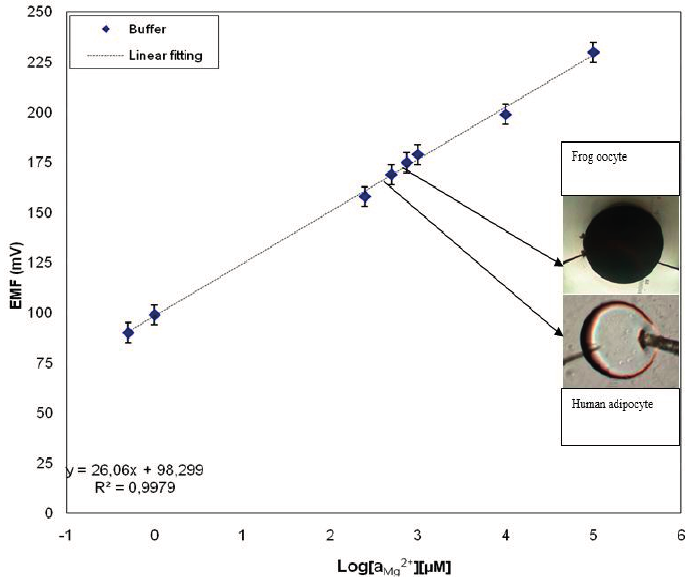
Figure 7. A calibration curve showing the electrochemical potential difference between the Mg 2+ -selective ZnO nanorod-covered and the Ag/AgCl reference microelectrode vs. the Mg 2+ concentration. Insets show images of human adipocytes and frog oocytes with arrows pointing at measured intracellular levels of Mg 2+ for the respective cells